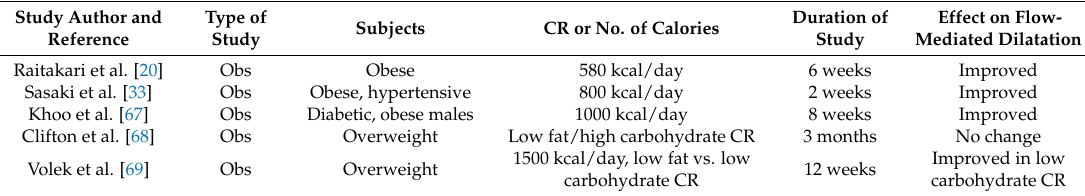
Table 3. Summary of studies showing the effect of fasting or caloric restriction on endothelium- dependent flow-mediated dilatation in >20 human